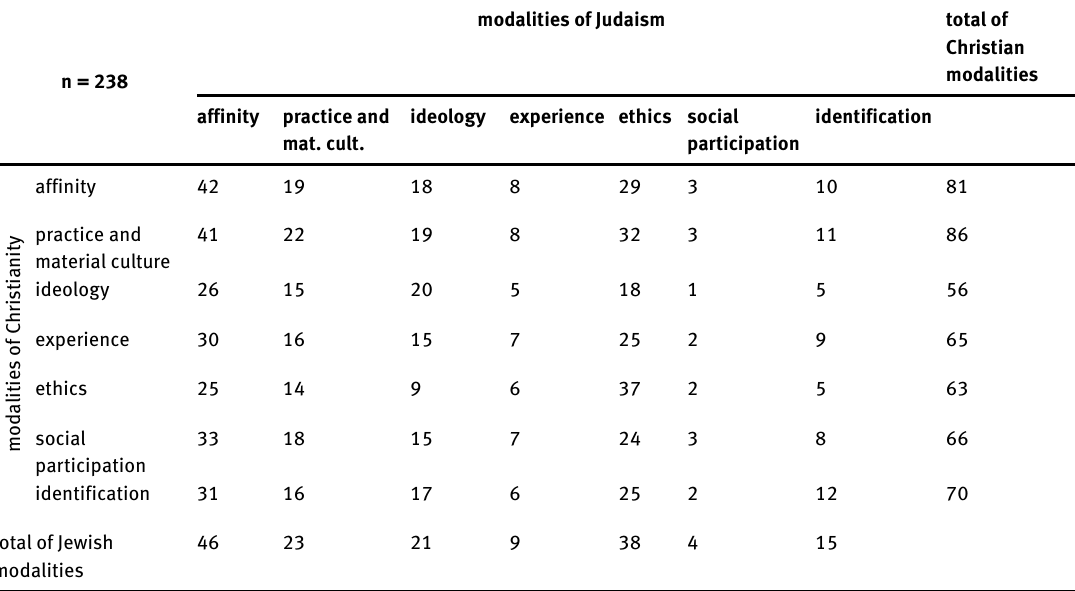
Table 9 specifies the combinations of modalities within the group. Table 9. Combination of modalities within the MRB group Christianity – Judaism